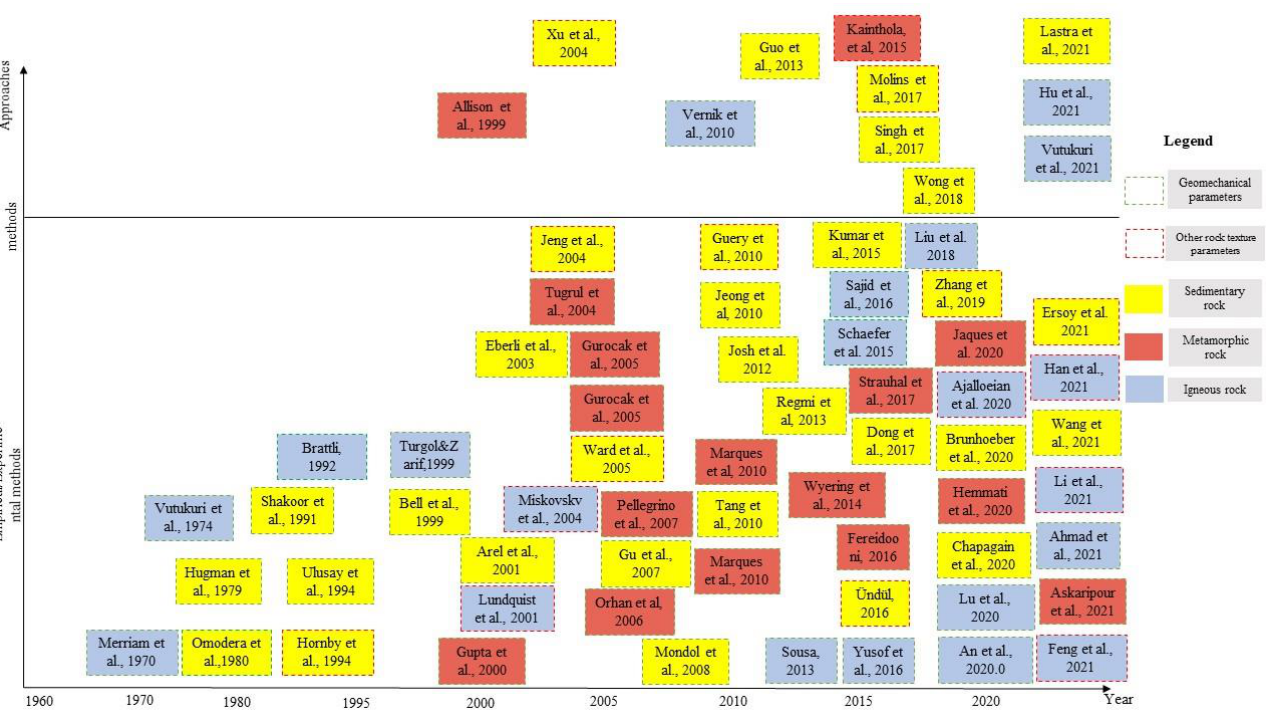
Figure 4. Main work on the effects of rock mineralogy on the geomechanical parameters of rock [3,5,17,45,47 – 104].